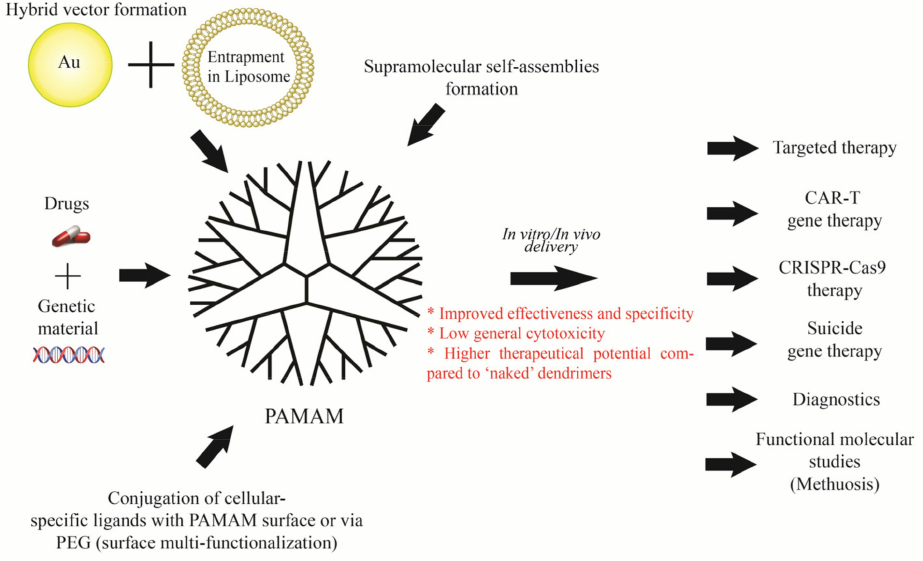
Figure 9. Modification approaches and practical applications of PAMAM dendrimers. Recent in vitro and in vivo proof-of-concept studies have demonstrated a multitude of new potential applications of PAMAM dendrimers by modifying their surface with a variety of cell-specific ligands, liposome en- capsulation, and fixation of their spatial structure by immobilization of gold particles within internal branching cavities. These modification approaches seem to move the use of PAMAM dendrimers closer to anticancer targeted therapy involving commercially available chemotherapeutic agents, along with genetic material enhancing its therapeutic effect. The use of the PAMAM dendrimer also appears promising for CAR-T- and CRISPR-Cas9-based therapies. The use of PAMAM dendrimer also seems promising for CAR-T- and CRISPR-Cas9-based therapies as well as diagnostics and molecular functional